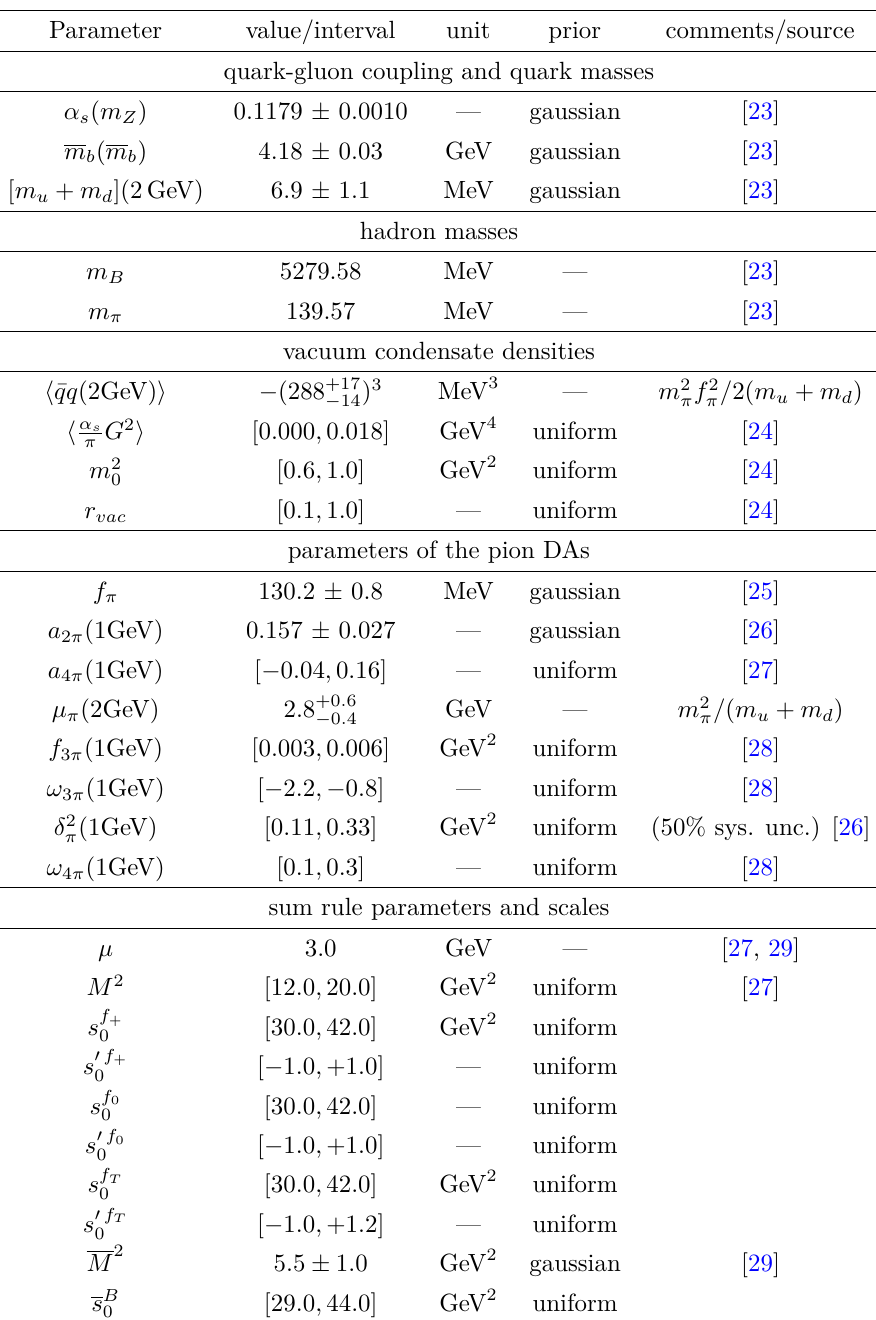
Table 1 . Input parameters used in the numerical analysis of the two-point sum rules for the f B decay constant and LCSRs for ¯ B → π form factors. The full prior distribution is a product of uncorrelated individual priors, which are either uniform or Gaussian distributed. Gaussian priors cover the intervals at 68% probability, and their central value corresponds to the mode. For practical purpose, variates of the gaussian priors are only sampled inside their respective 99% intervals. The prior intervals of the duality threshold parameters are chosen such that the peaking posterior distribution is fully